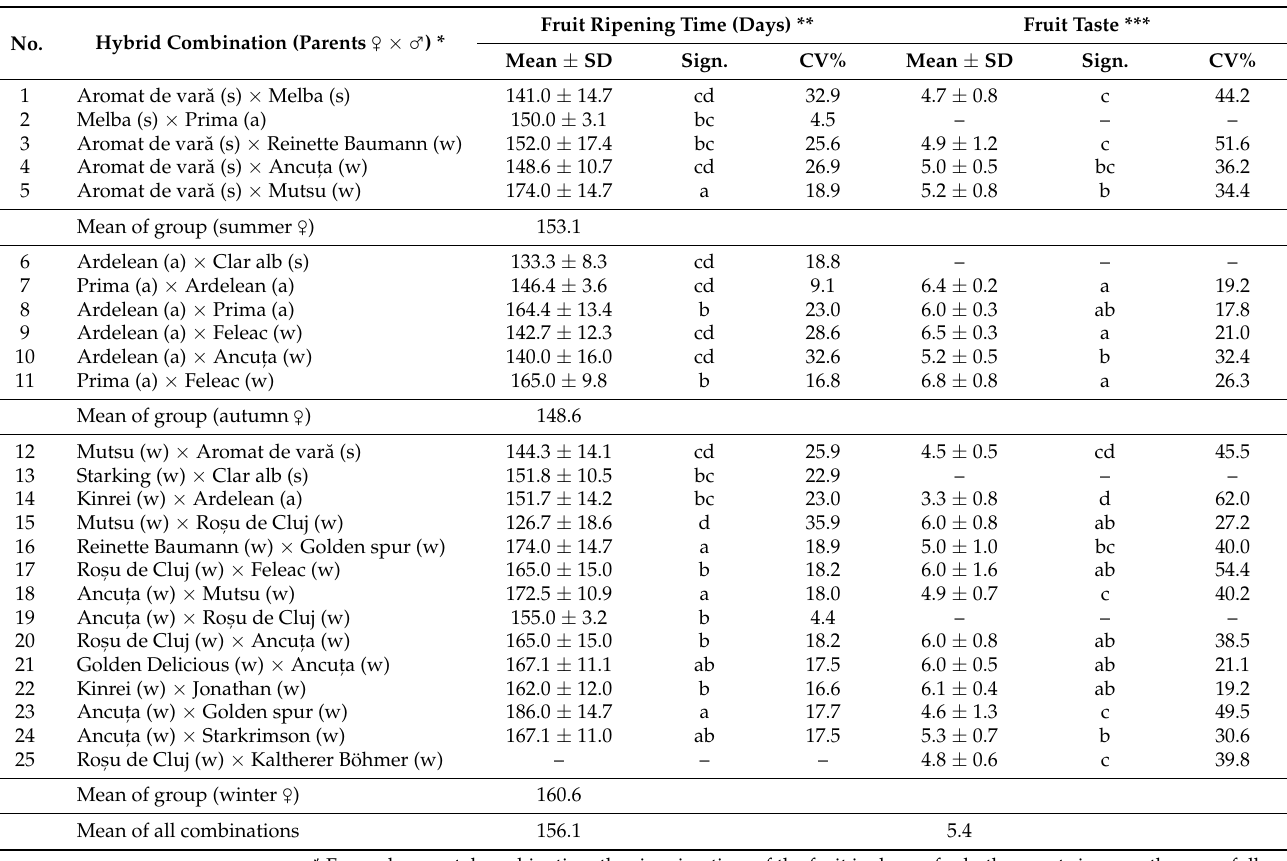
Table 5. Fruit ripening time and fruit taste in F 1 apple hybrids according to